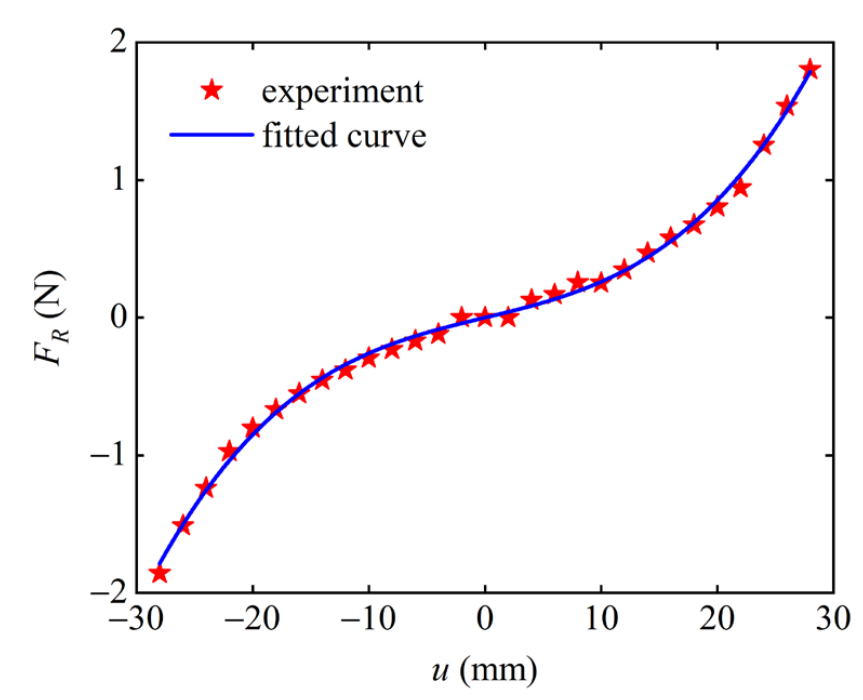
Figure 3. Nonlinear restoring force curve.